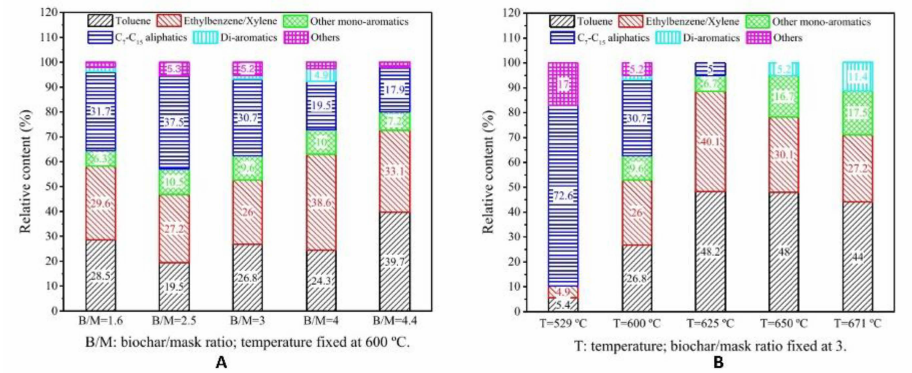
Figure 5. Liquid product distributions from mask pyrolysis with ( A ) different biochar-to-mask ratios at 600 ◦ C and ( B ) multiple temperatures at the biochar-to-mask ratio of 3. Reproduced with permission from Ref. [65]. Copyright 2021 Elsevier Ltd.